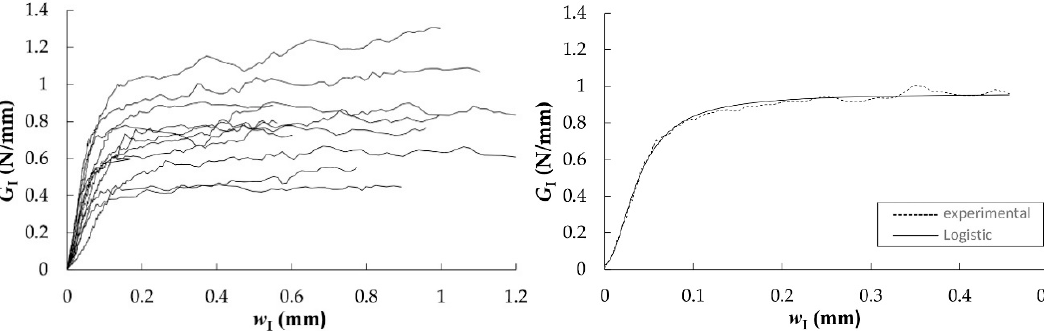
Figure 10. Cohesive laws in RL (left) and TL (right). Mean cohesive law is highlighted in bold. Table 5. Logistic function parameters ( A 1 , A 2 , p, and w I0 ), maximum stress ( σ Iu ) and relative displacement ( w Iu ), as determined by CBBM equations, from specimens with the RL crack system. ref